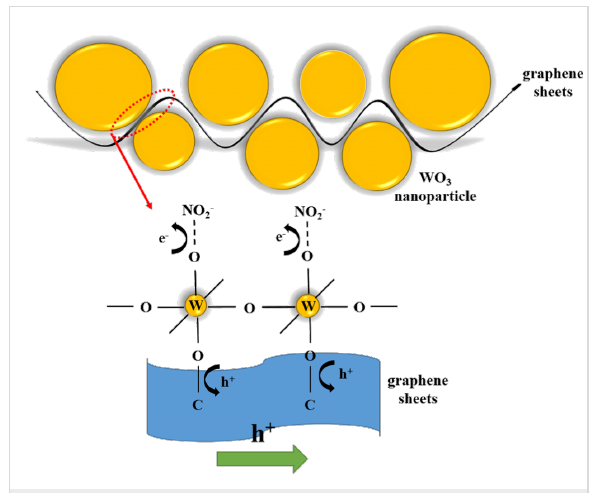
Figure 5: Proposed NO 2 -sensing mechanism of GR–WO 3 composites at room temperature and electron transfer between WO 3 nanospheres and graphene